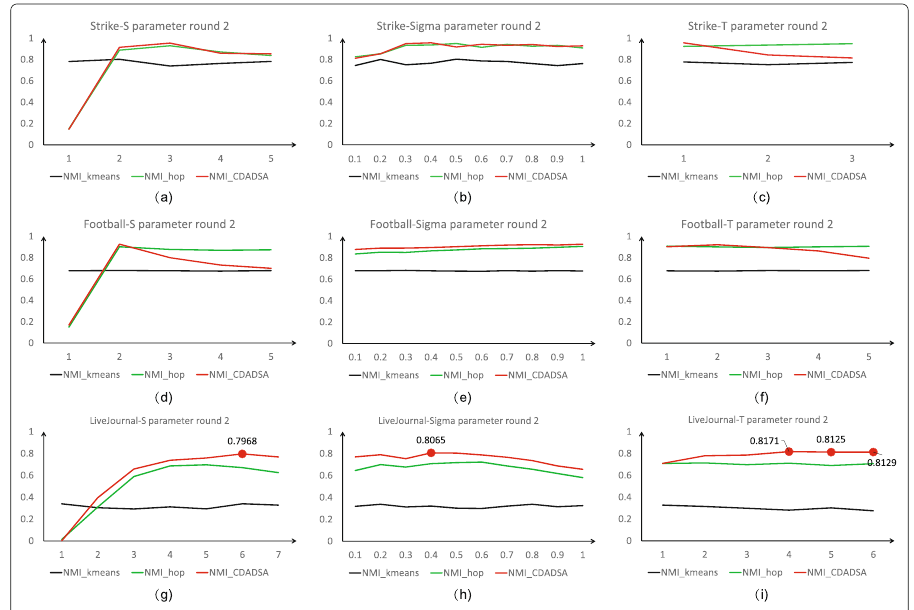
Fig. 8 The second-round experimental results of the parameter